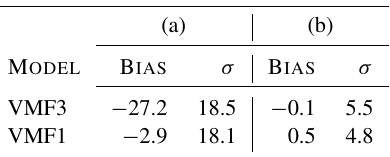
Table 3. Bias and standard deviation in slant hydrostatic delay (cid:49)L h (mm) at 5 ◦ elevation between the reference solution from ra- diosonde data and the other solutions. In the left part of the table (a), the zenith delays as well as the mapping functions come from the respective model; in the right part (b), the zenith delays from the radiosonde data are used for all models, so that the results reflect only the difference in mapping